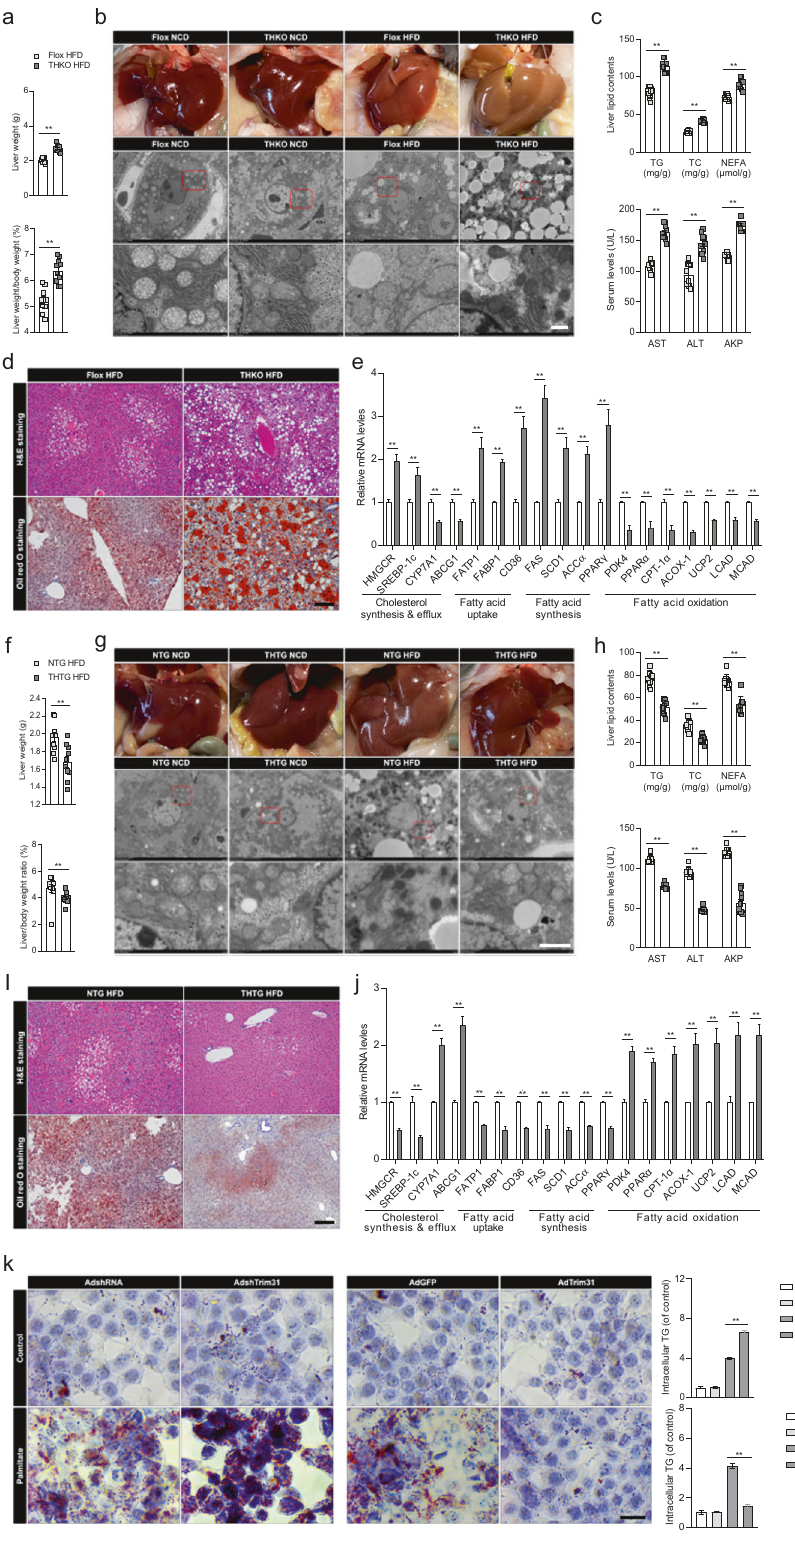
Trim31-mediated ex vivo gene therapy facilitates the mitiga- liver steatosis, insulin resistance and in fl ammation (Fig. 4a and tion of fatty liver . To better con fi rm the inhibitory effect of Trim31 Supplementary Fig. S8a). Unsurprisingly, using ex vivo cultured and transduced hepatocytes, the mice with hepatocyte-speci fi c Trim31 on steatohepatitis, the ex vivo gene therapy intervention approach by gain-of-function (THKO)(LV + ) exhibited a remarkable decrease lentivirus loaded with mouse full-length Trim31 sequences (LV- in HFD-induced liver weight, body weight, LW/BW ratio, AST Trim31) or human full-length Trim31 sequences (LV-hTRIM31) and ALT levels, and hepatic lipid deposition, compared to the was employed to further evaluate the role of Trim31 on mitigation of NATURE COMMUNICATIONS| (2022) 13:1052